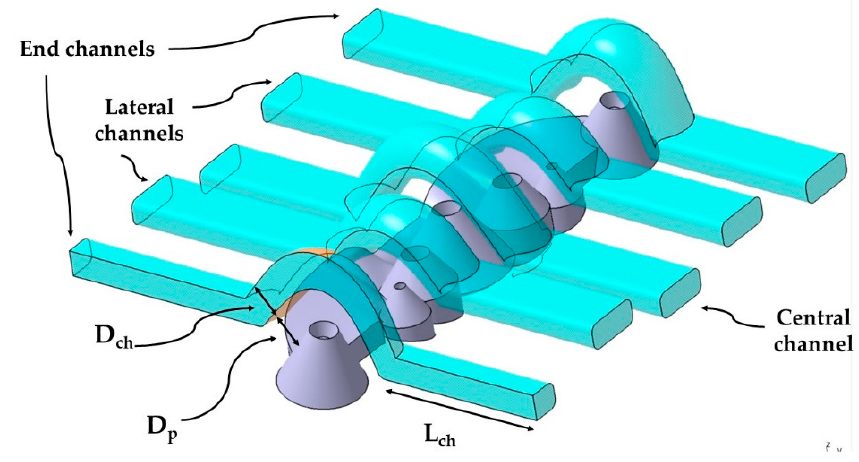
Figure 8. Parameters D p , D ch , y L ch on the design of the new conformal channels.